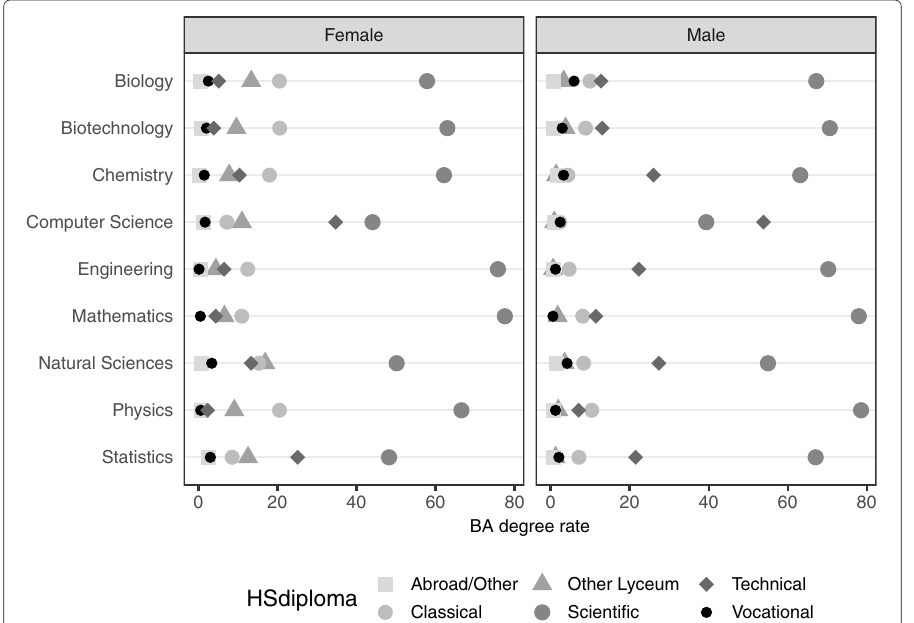
Fig. 2 BA degree rates in STEM courses by gender and type of high school. Cohort of freshmen enrolled in